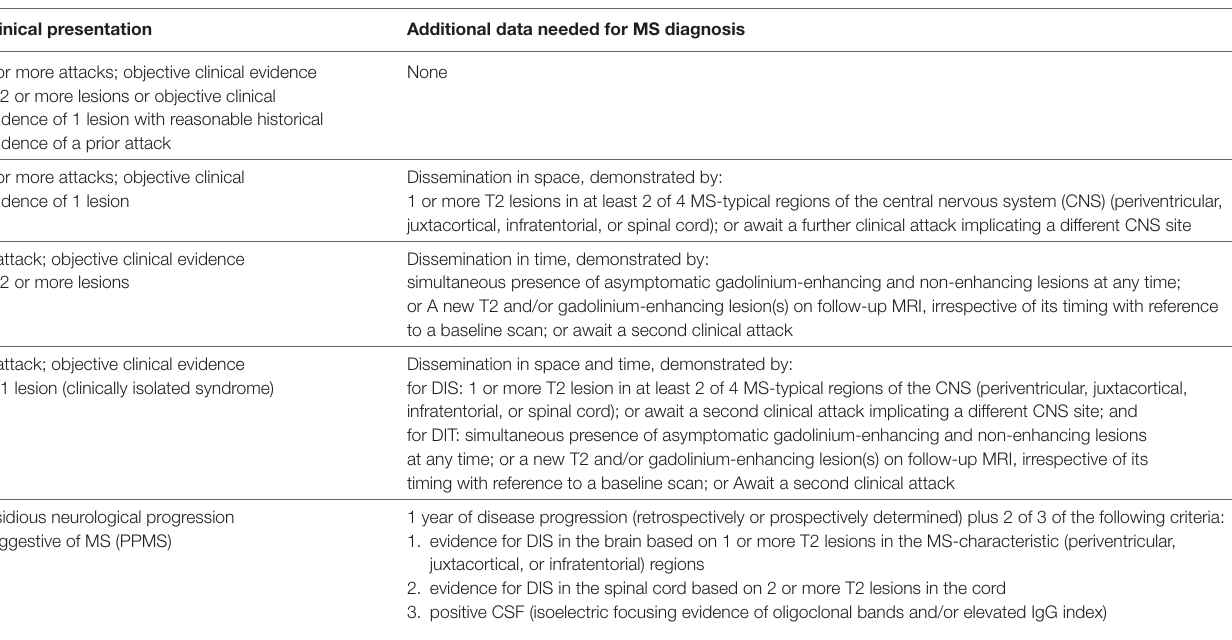
TAble 1 | 2010 Mc Donald criteria for multiple sclerosis (MS) diagnosis